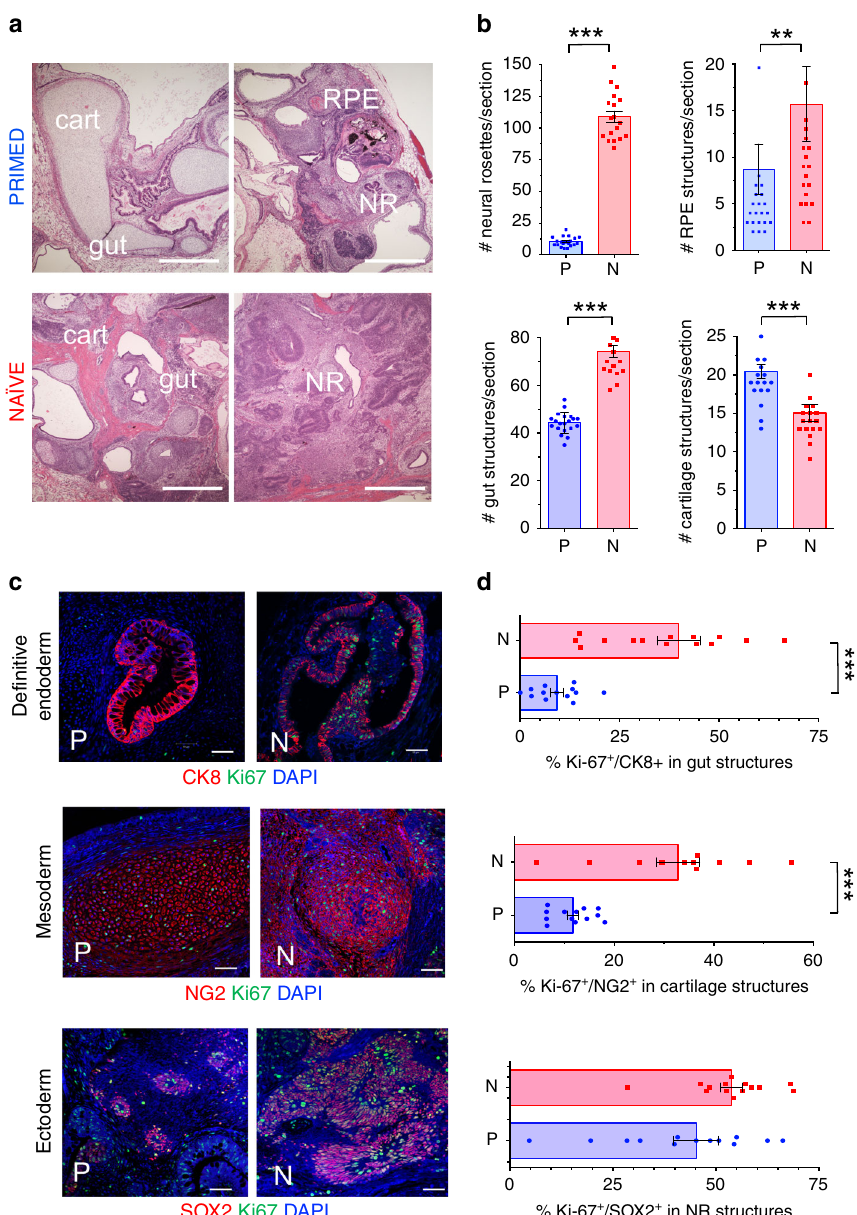
Fig. 1 Teratoma organoid quanti fi cations in isogenic non-diabetic hiPSC. The non-diabetic human fi broblast-hiPSC line C1.2 (Supplementary Data 1) was cultured in parallel in either primed, conventional E8 (PRIMED; P) or LIF-3i/MEF (NAÏVE; N) conditions prior to parallel injections into sibling NOG mice (5 × 10 6 cells/site) for teratoma assays. Paraf fi n sections of 8 week-old N vs. P teratomas were evaluated and individual microscopic sections quanti fi ed by ( a , b ) H&E staining (cartilage (cart); neural rosettes (NR); retinal pigmented epithelium (RPE) (Scale Bar = 500 μ m), or ( c , d ) Immuno fl uorescence (IF) staining (Scale Bar = 50 μ m). Shown are individual tissue section measurements from at least 3 independent teratoma experiments quanti fi ed for organoid structures and markers of endodermal (Cytokeratin 8 + (CK8); gut/glandular structures), mesodermal (NG2 + chondroblasts), and ectodermal (SOX2 + neural rosettes) lineages along with the proliferation marker Ki-67. ** p < 0.01; *** p < 0.001 (Mann-Whitney